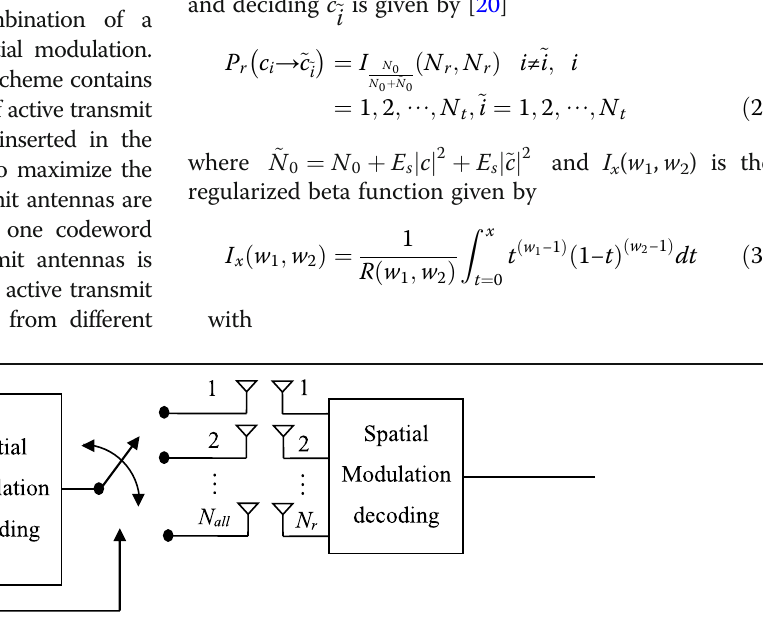
Fig. 1 Block diagram of the conventional spatial modulation scheme [18,